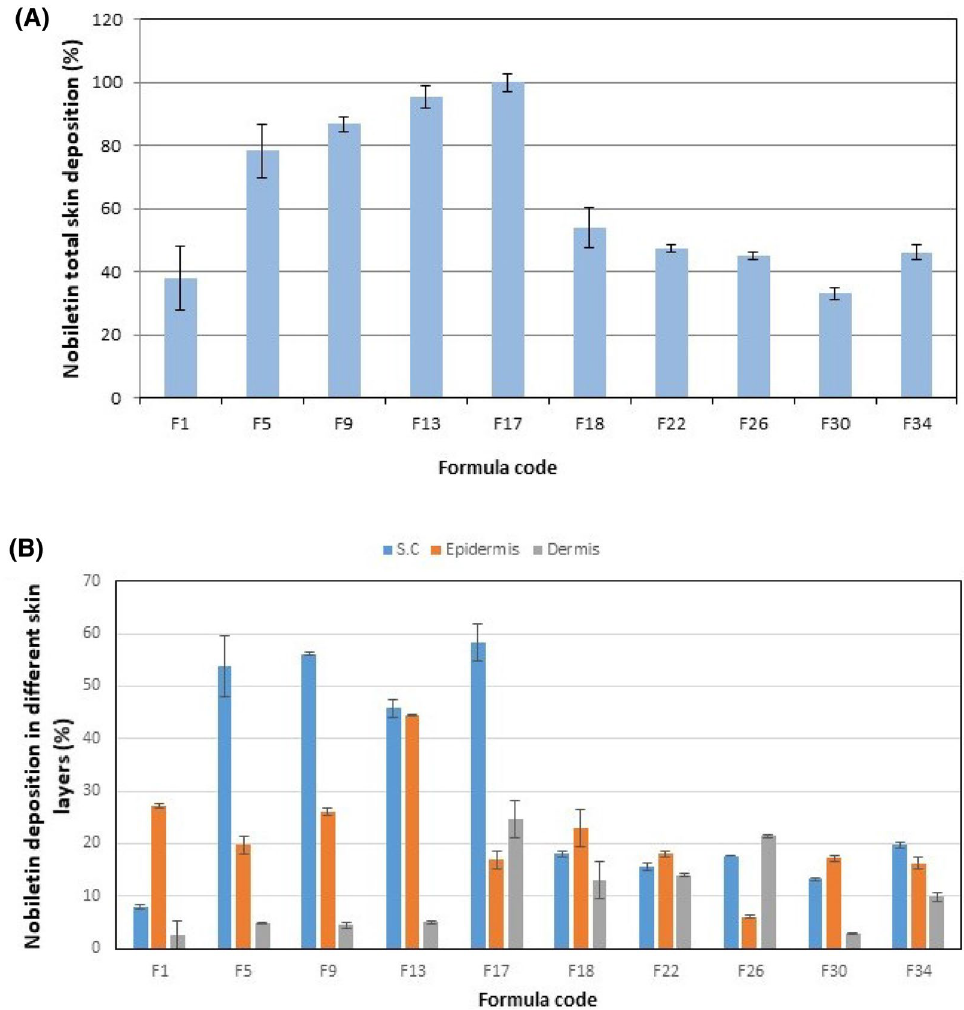
Figure 1. ( A ) Total deposition percent of nobiletin in skin layers ( B ) Deposition percent of nobiletin in S.C, epidermis and